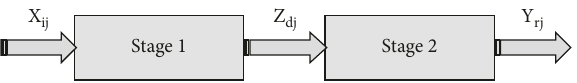
Figure 2: General layout of the two-stage